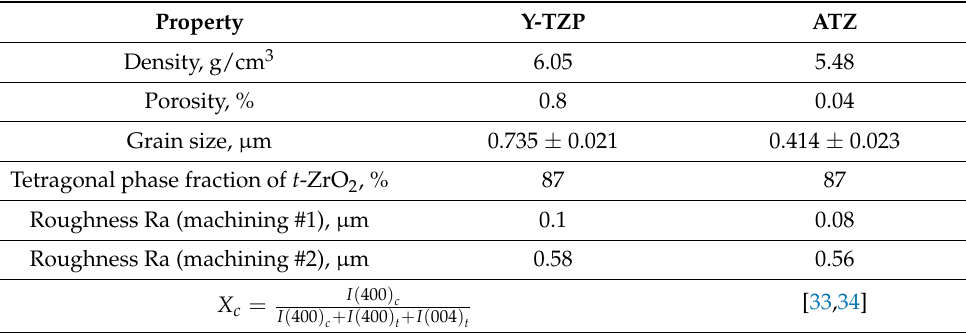
Table 1. Microstructural parameters of yttria-stabilized zirconia (Y-TZP) and alumina-zirconia composite